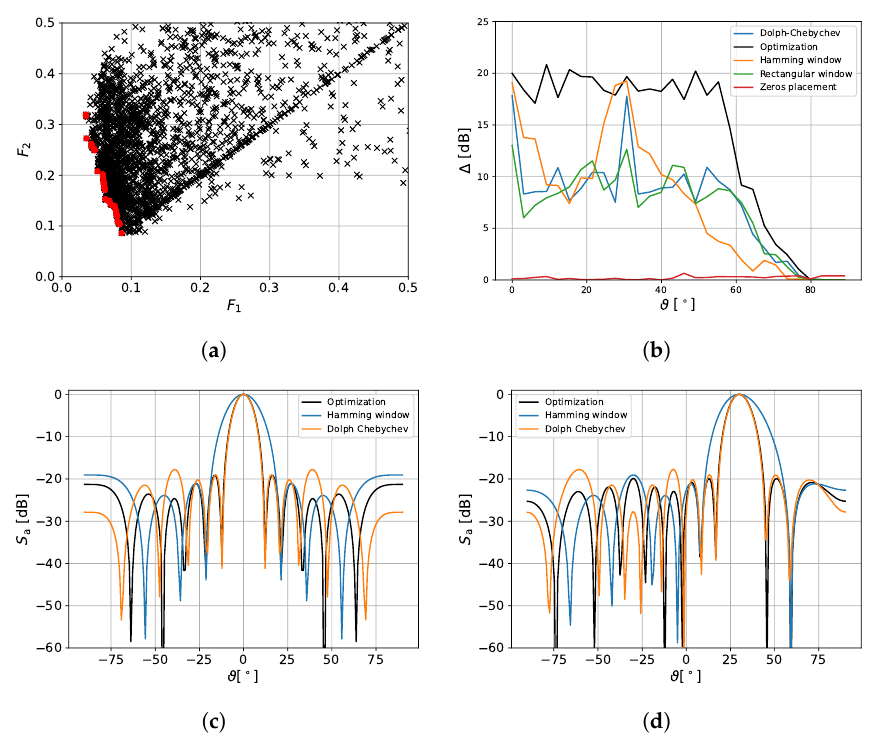
Figure 12. Results of multi-criteria optimization with 60 generations and 60 individuals in each generation. ( a ) Pareto front of the quantization error of the magnitude and the phase after the multi- criteria optimization, the points of the Pareto front is denoted by red dots; ( b ) Comparison of effect of 3-bit quantization for array factor obtained by different methods. The result of optimization—black line; ( c ) Comparison of array factors obtained by different methods with 3-bit quantized excitation for ϑ = 0 ◦ ; ( d ) Comparison of array factors obtained by different methods with 3-bit quantized excitation for ϑ = 30 ◦